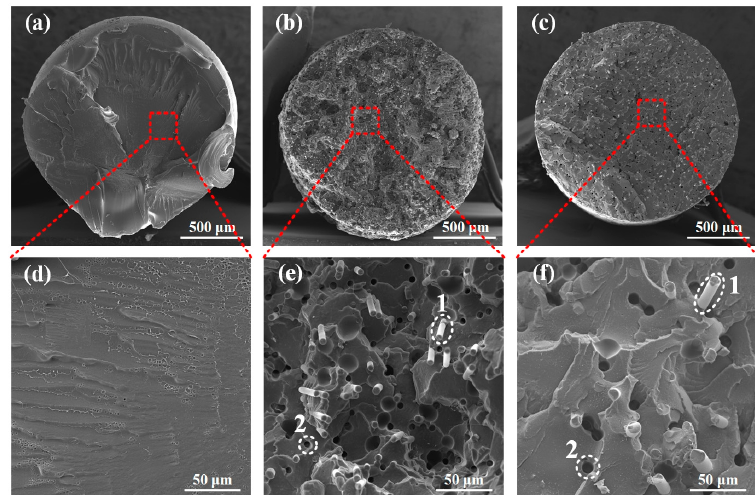
Figure 4. SEM images of printing filaments for ( a ) PA, ( b ) PACF, ( c ) PAGF, and the corresponding enlarged figures ( d ), ( e ), and ( f ) (dashed circles 1 indicate the short fibers and dashed circles 2 indicate dark voids caused by the pulling out of the short fibers). Polymers 2020 , 11 , x FOR PEER REVIEW